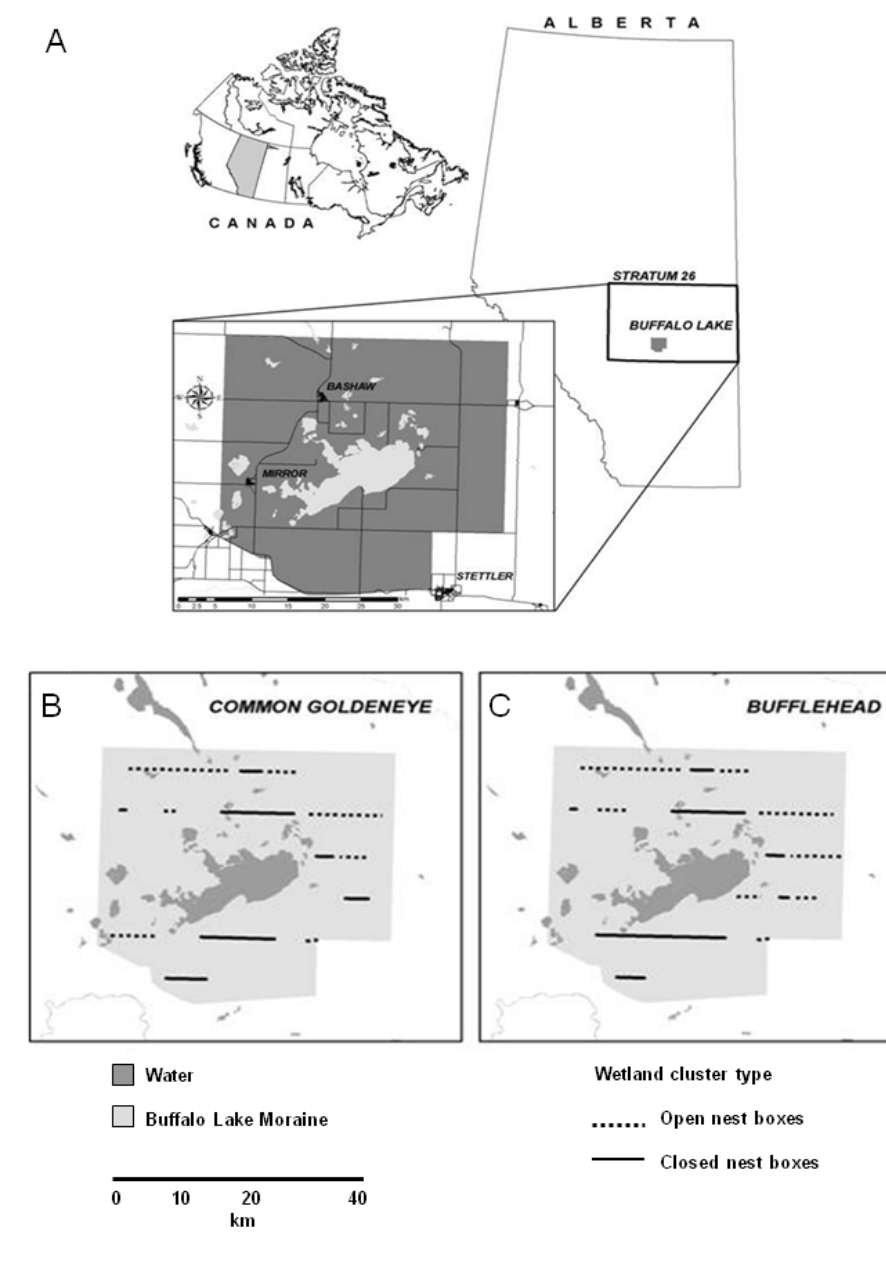
Fig. 1. Location of Buffalo Lake Moraine and Stratum 26 (A), and locations and spatial extent of clusters of wetlands where nest boxes were open (dashed lines) or closed (solid lines) for use by Common Goldeneye, Bucephala clangula (B), and Buffleheads, Bucephala albeola (C), in central Alberta, Canada in 2004. All nest boxes were open for occupancy by Common Goldeneye and Bufflehead in